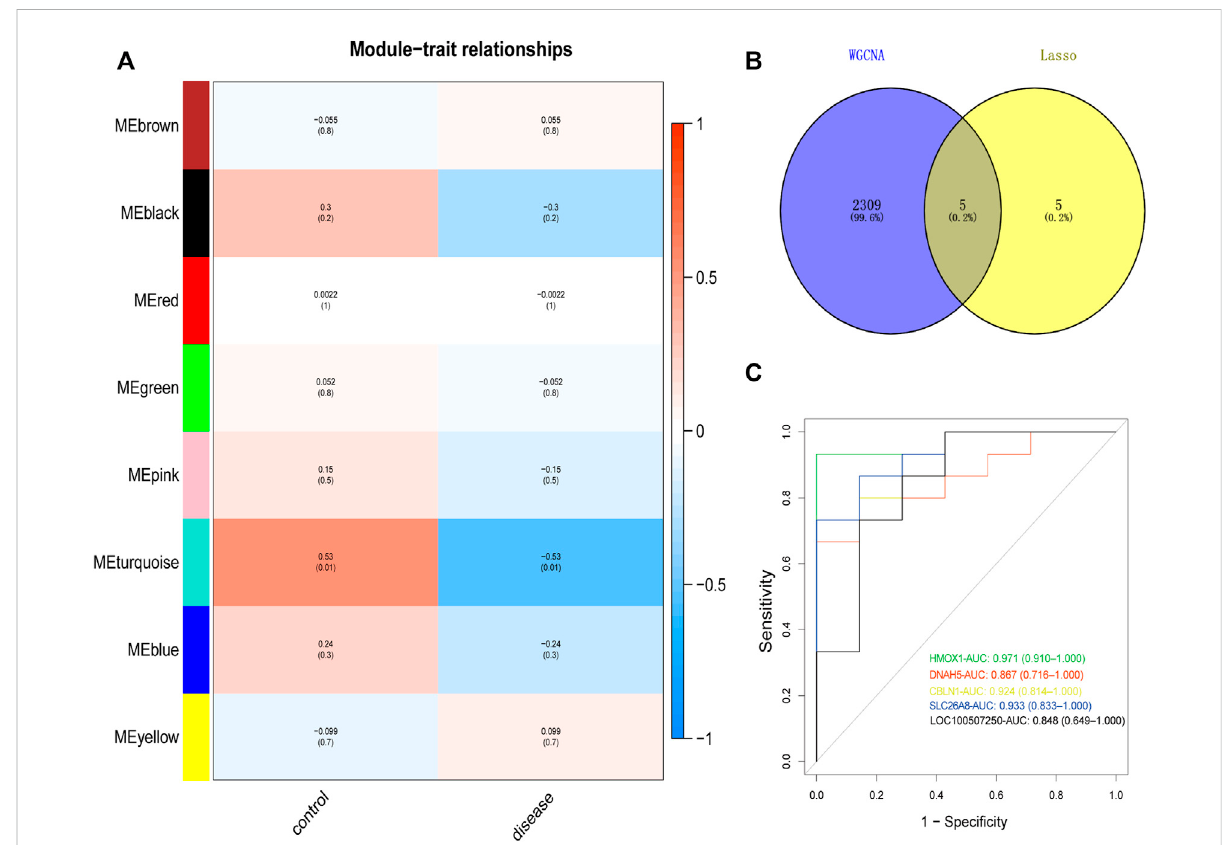
FIGURE 3 Identi fi cation and ROC curves of diagnostic markers. (A) Heat map showed positive and negative correlation of the gene module in the PCOS and normal samples, respectively. (B) Venn plot was performed to show the intersection of potential target genes using WGCNA and Lasso. (C) The ROC curve of the diagnostic power of fi ve target genes ( CBLN1 , DNAH5 , HMOX1 , SLC26A8 , LOC100507250 ). ROC curves, receiver operating characteristic curves; PCOS, Polycystic ovary syndrome; WGCNA, weighted gene co-expression network analyses; LASSO, least absolute shrinkage and selection